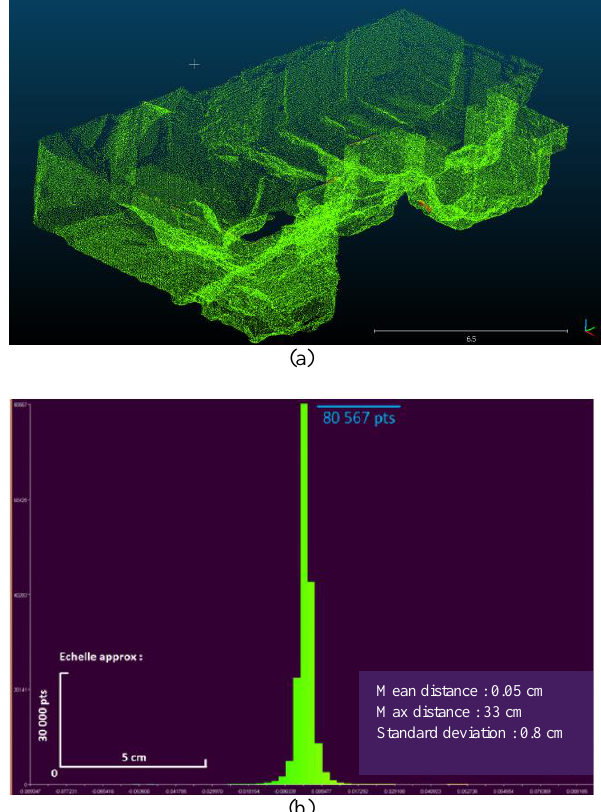
Figure 10. Assessment of the mesh model of the basement floor, compared to the registered point clouds; a) color-coded point cloud regarding the deviations: red and blue points stand for outliers, green for inliers; b) histogram of the